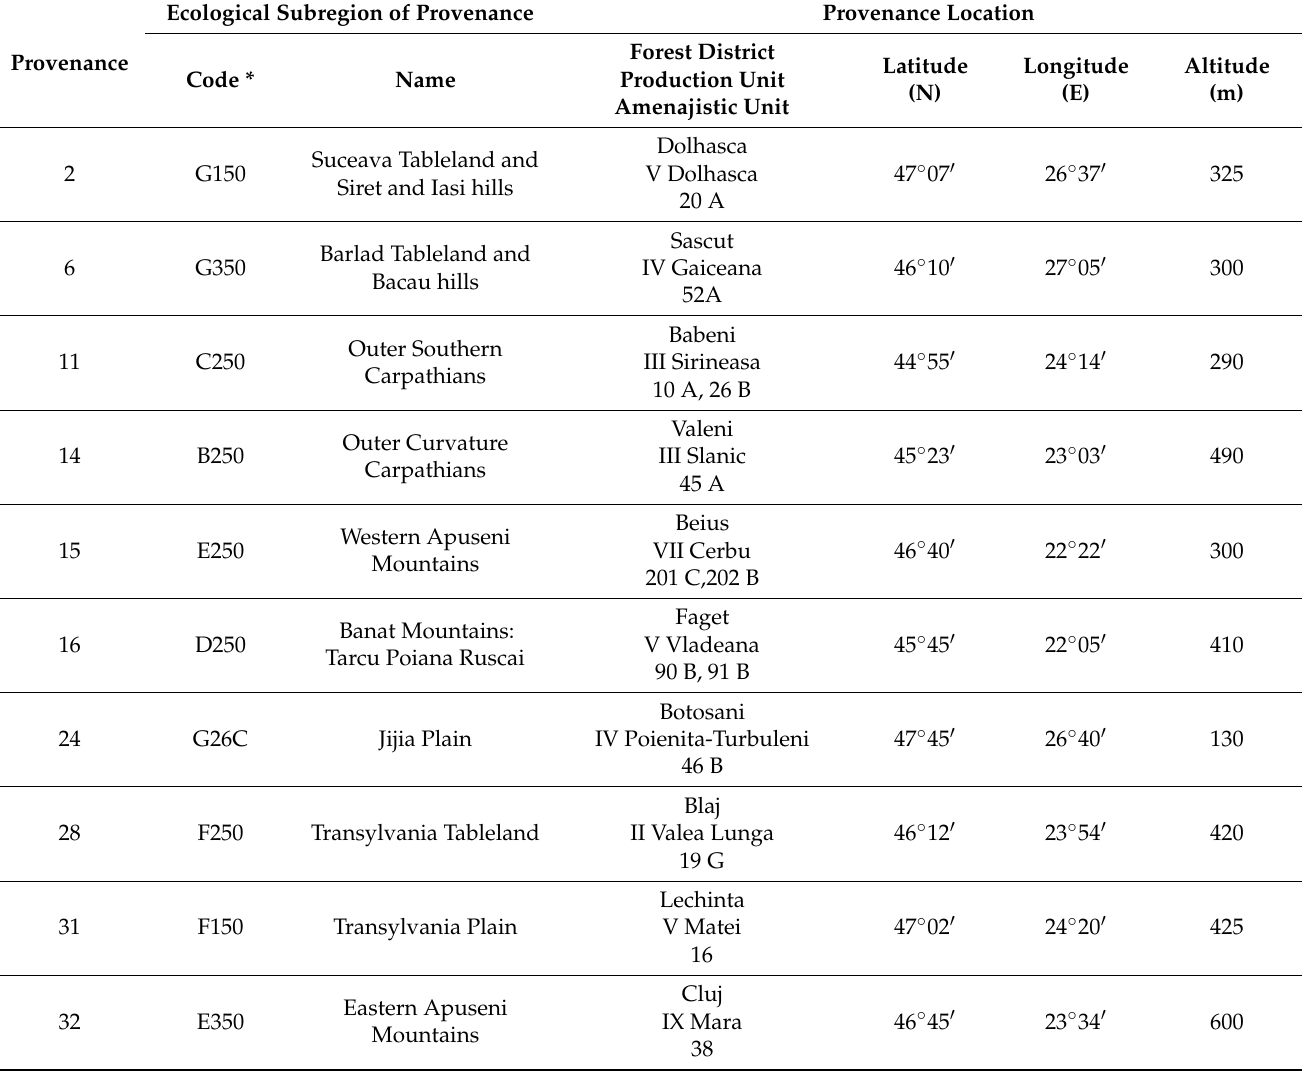
Table 2. Location and geographical coordinates of the tested provenances in the FAN comparative